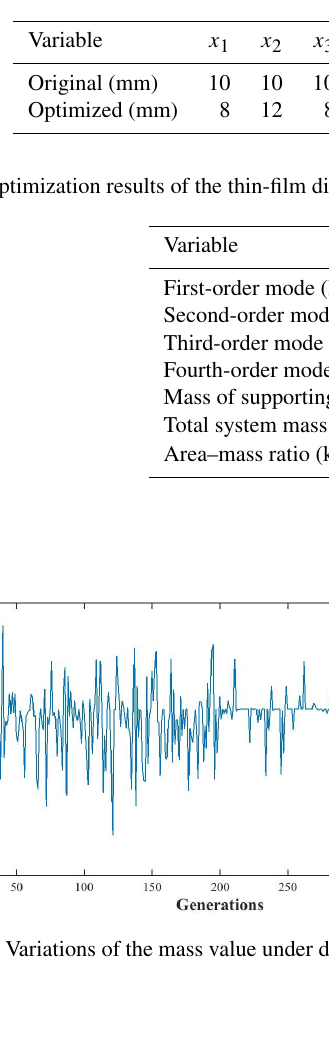
Table 8. Structural parameters of the thin-film diffraction imaging system.